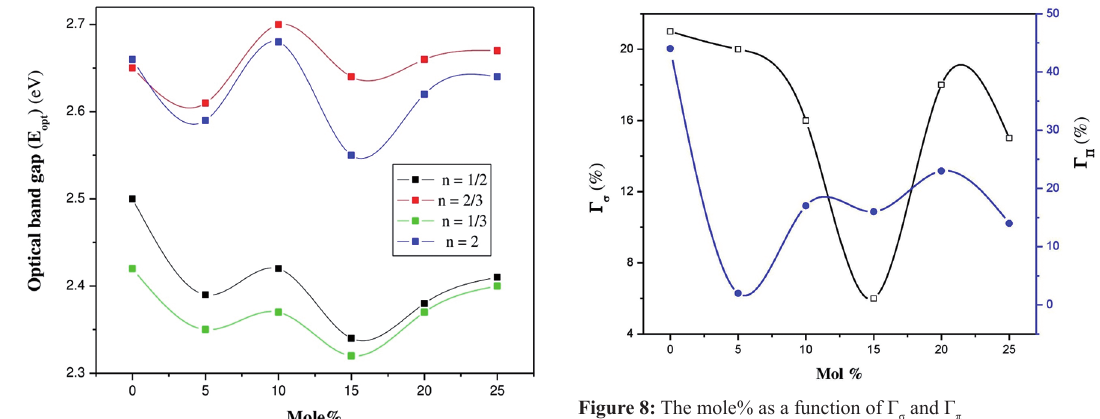
Figure 8: The mole% as a function of Γ